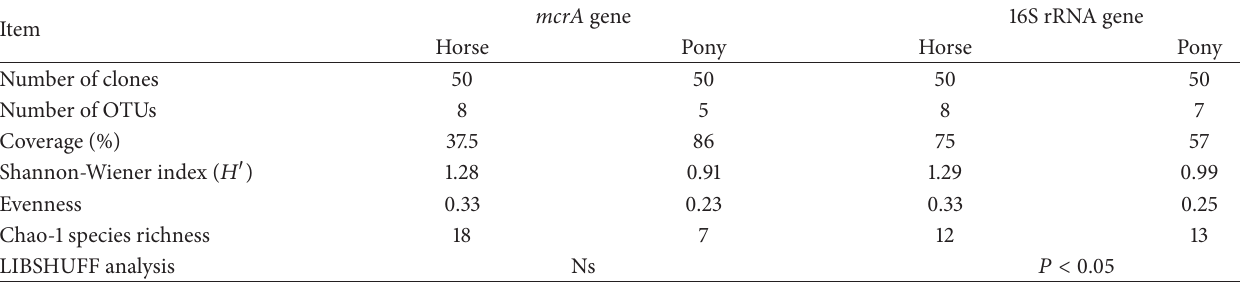
Table 5: General information and diversity indices of the mcrA gene and archaeal 16S rRNA gene clone libraries recovered from microbial populations in the fecal contents of horse and